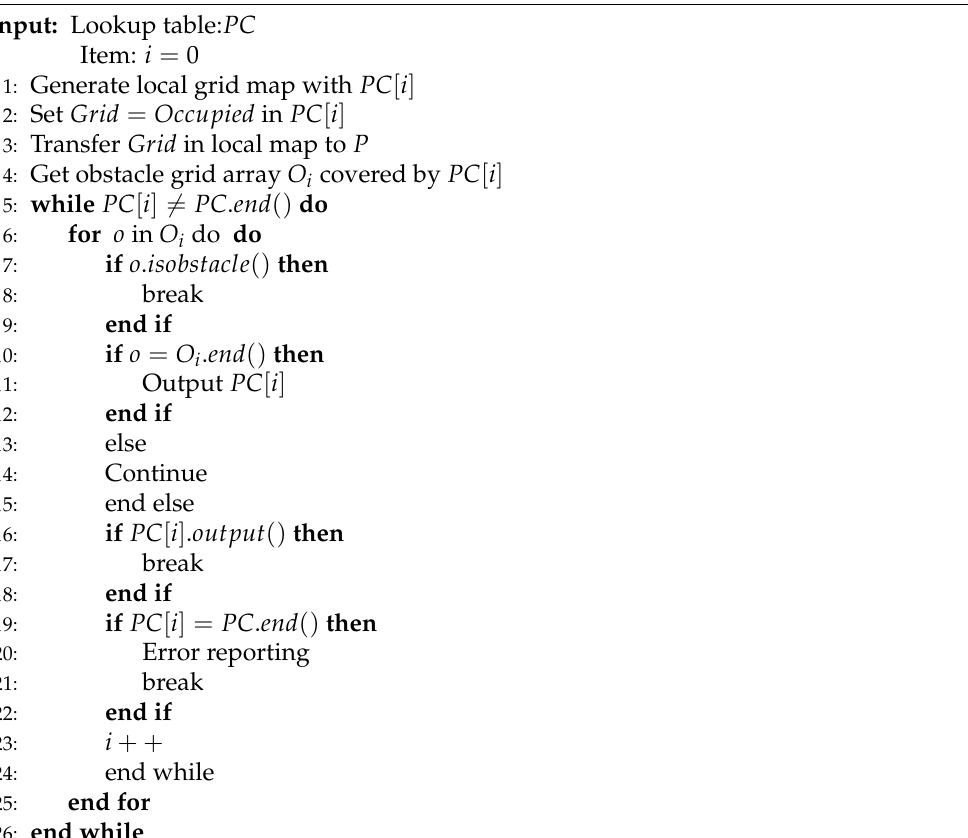
Figure 7. Example of safe online path envelope constraint extraction: Left : Generated a local map with maximum outer constraints at this point. Right : The constraints of the current point obtained by the constraint search. Among them, L − MAP is the local map, PC is the lookup table, the numbers in square brackets represent the corresponding elements in the array, PC [ 0 ] is the largest external constraint in the lookup table, O 0 is the grid covered by PC [ 0 ] on L − MAP , PC [ i ] is the found outer envelope, and O i is PC [ i ] Grid overlaid on L − MAP . Algorithm 2 Find constraint in path point P